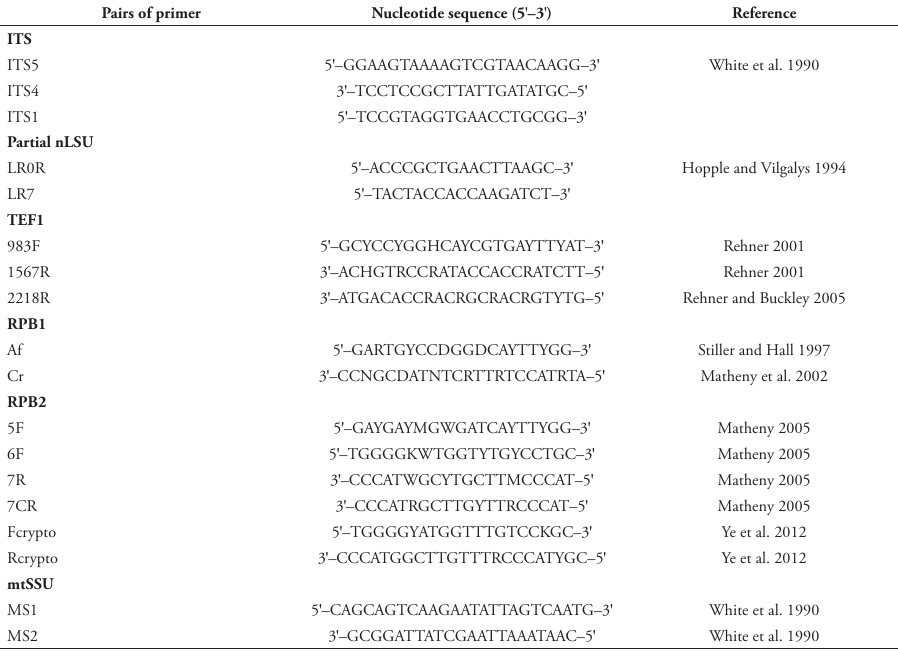
Table1. Sequencing primers used in this